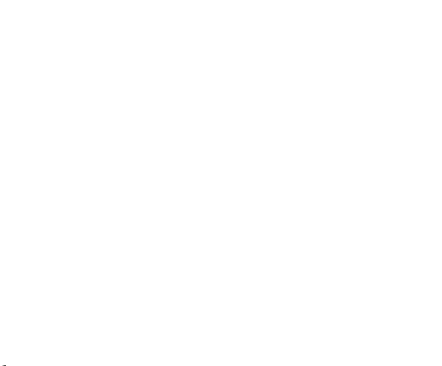
Table 2. MIC of T. indica extract against tested bacterial